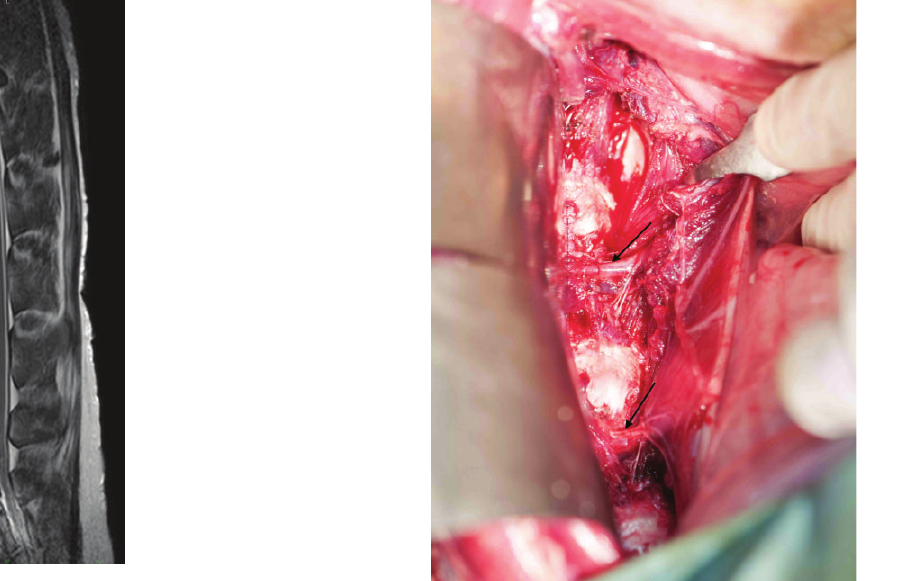
Figure 1: 3T sagittal T2-weighted MRI of ovine lumbar spine demonstrating concave elongated vertebral bodies, intervertebral discs, and the persistence of the spinal cord into the sacral region.